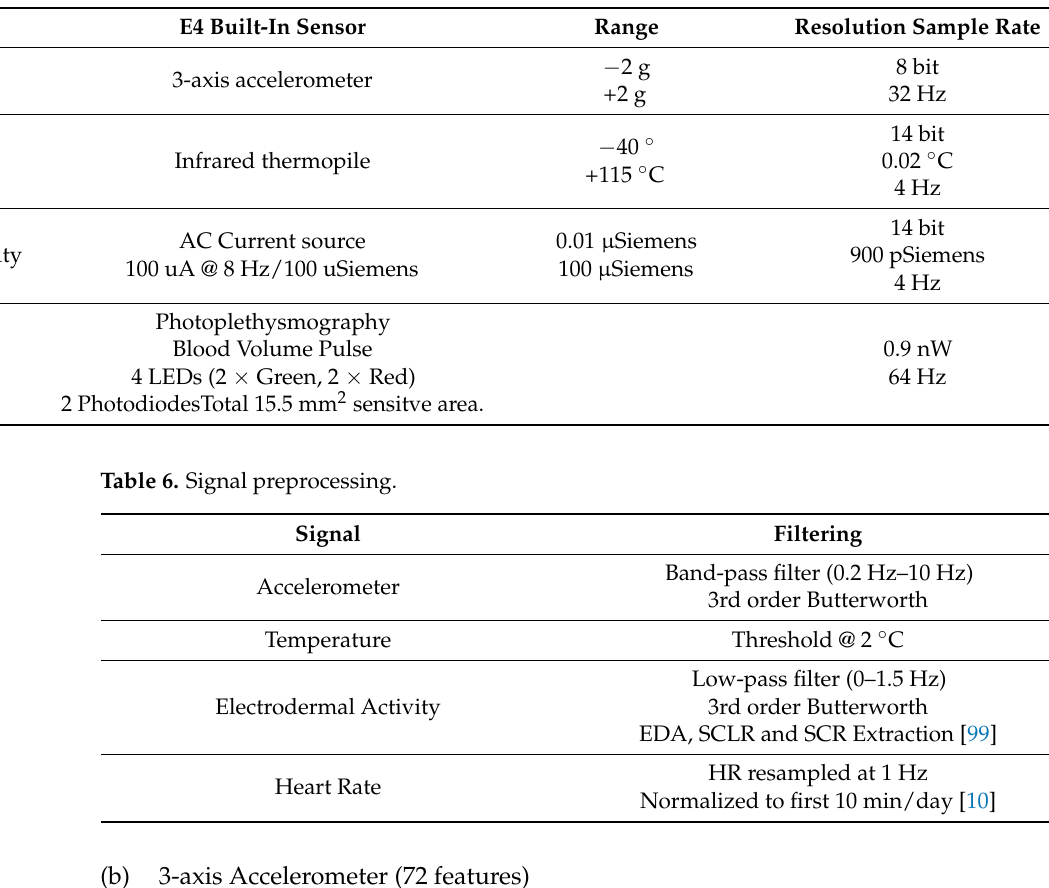
Table 5. Empatica E4 built-in sensors.